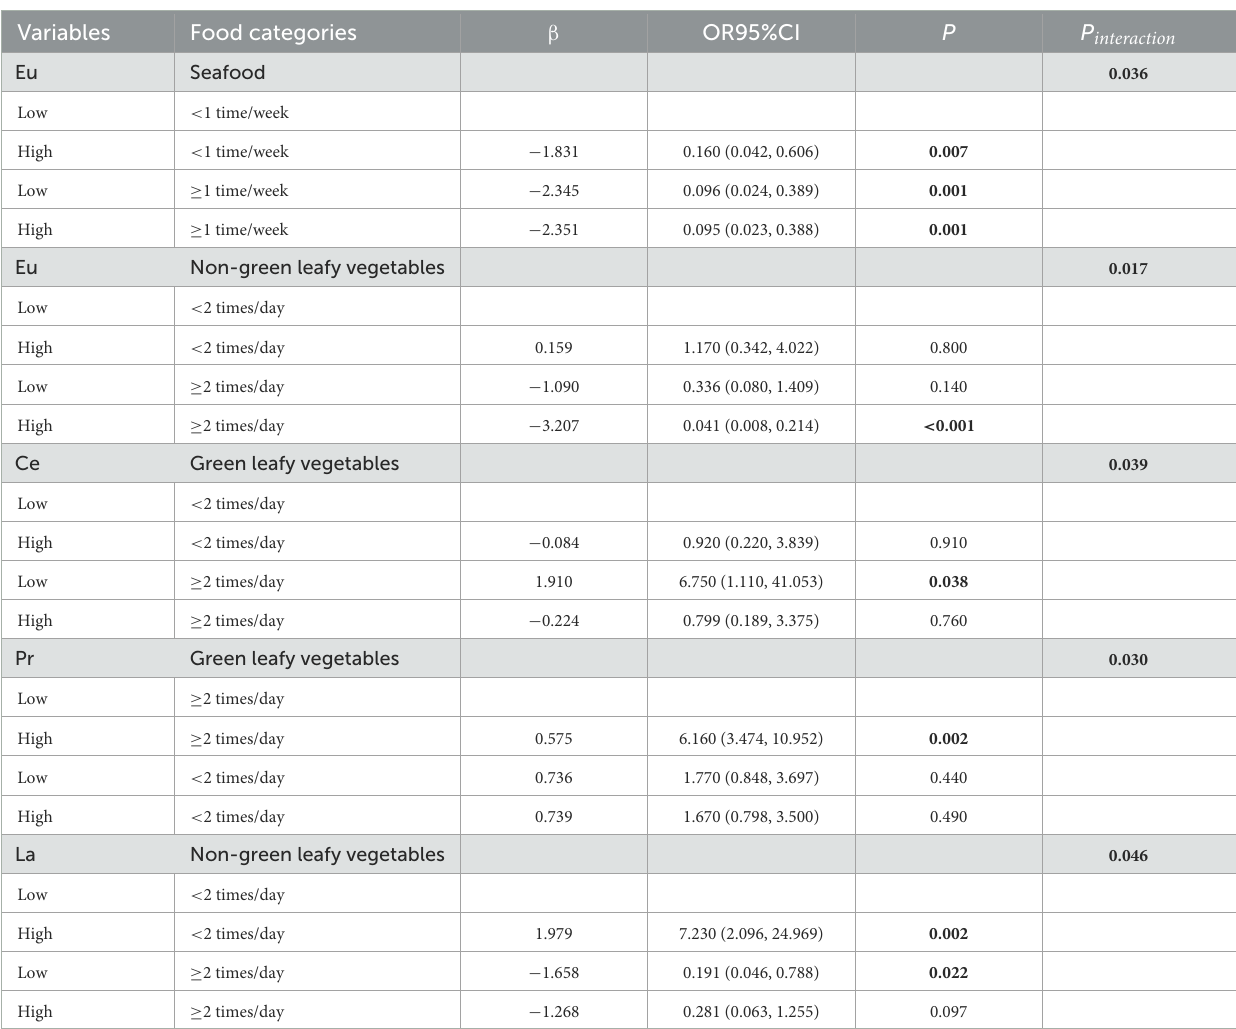
TABLE 2 The combined effect of the REE and dietary intakes for tongue cancer.